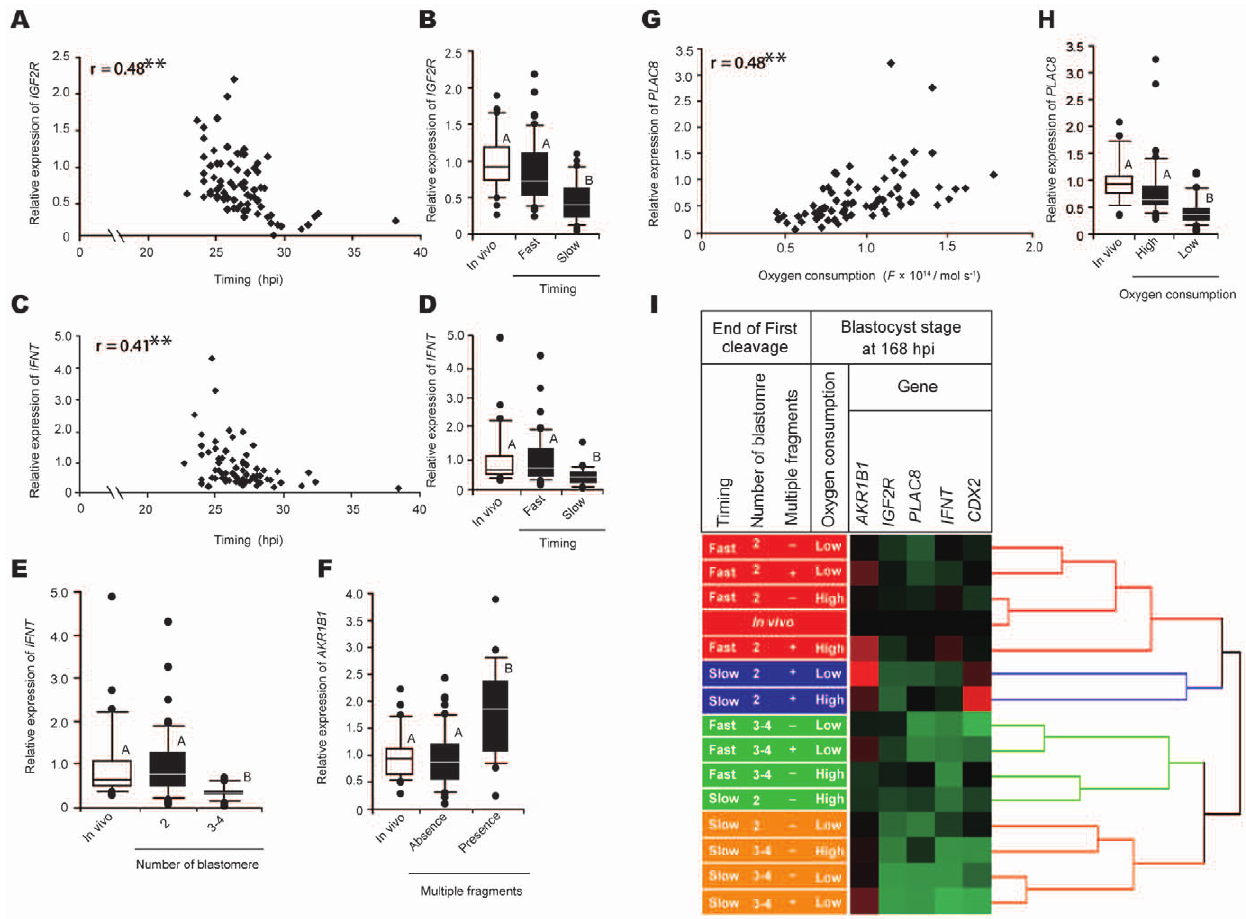
Figure 5. Factors relating to expression of IGF2R , IFN T , AKR1B1 , and PLAC8 at the blastocyst stage. Relationship between IGF2R and timing of the first cleavage ( A and B ), IFN T and timing of the first cleavage ( C and D ), IFN T and the number of blastomeres at the end of the first cleavage ( E ), AKR1B1 and the presence or absence of multiple fragments at the end of the first cleavage ( F ), and PLAC8 and oxygen consumption at the blastocyst stage ( G and H ) are shown. Relative expression is shown as the fold change from the mean value of in vivo –derived blastocysts, which was set at 1. **Coefficient of determination, r , was statistically significant based on simple regression analysis ( P , 0.01) ( A , C , and G ). Different letters indicate significant differences between groups based on one-way ANOVA followed by Fisher’s PLSD ( A,B P , 0.01) ( B , D , F , and H ). Gene expression in blastocysts classified based on timing, blastomere number, the presence or absence of multiple fragments at the end of the first cleavage, and oxygen consumption of blastocysts at 168 hpi ( I ). Embryos displaying similar patterns of expression for these five genes were grouped together on closely connected branches of the dendrogram with the same colors. The color map indicates normalized expression values that were based on in vivo –derived blastocysts for each gene examined. Red represents high expression; black, approximately equal expression; and green, low expression as compared with in vivo –derived blastocysts.